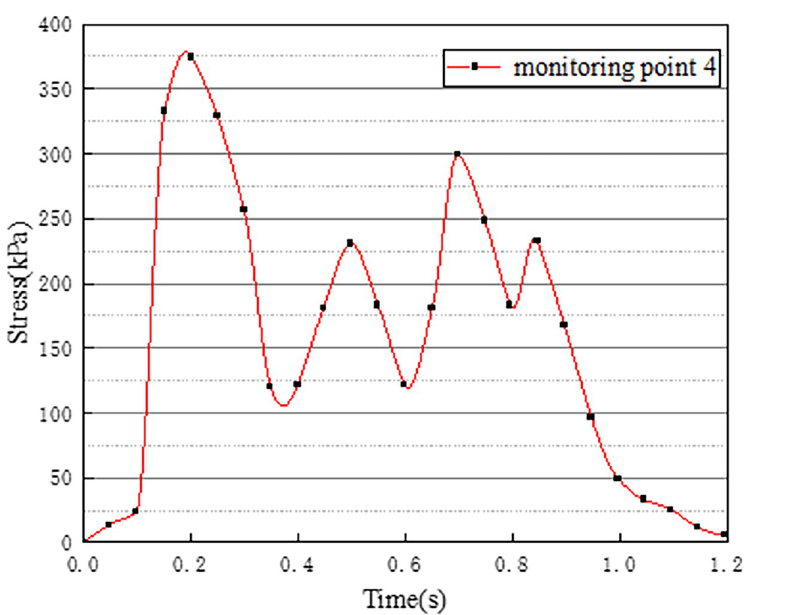
Fig 6. Stress time history curve of monitoring point